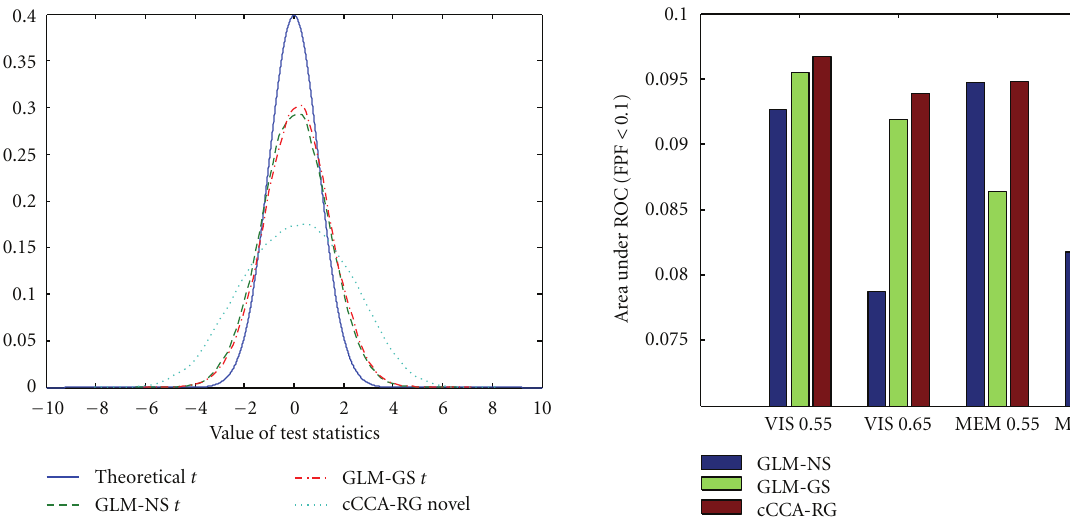
Figure 3: Distributions of the proposed CCA statistic (“cCCA- RG novel”) along with the conventional t -statistic used in the GLM using resampled resting-state data and contrast E-C for the memory paradigm. The di ff erence of the GLM-based t -statistic from a theoretical t -distribution (blue solid curve, DOF = 278) was mainly caused by the temporal correlation in fMRI signal. The novel CCA statistic has the widest profile because of the additional spatial modeling.